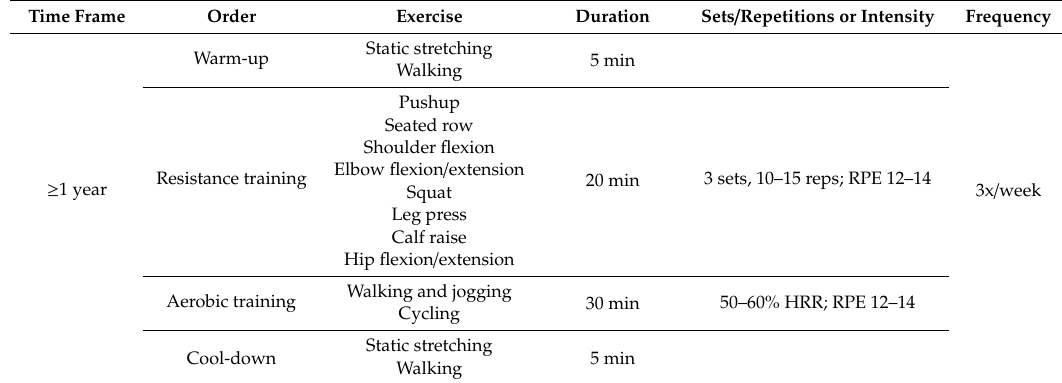
Table 1. Combined resistance and aerobic exercise (CRAE) training